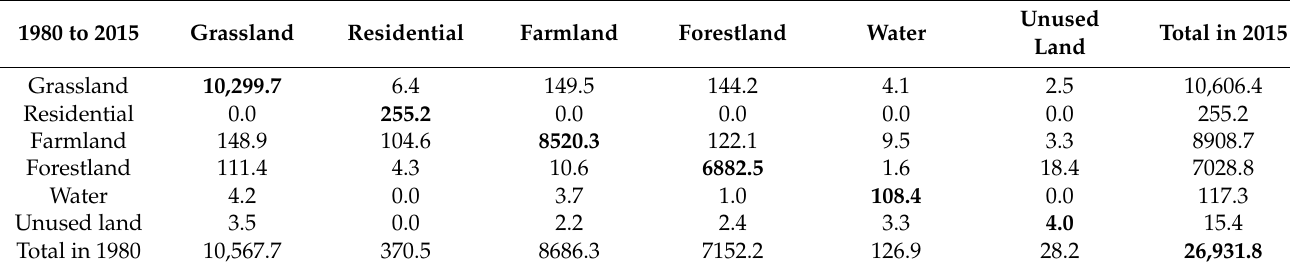
Table 6. Transition matrix of land-use change and total area of different land use from 1980 to 2015 in the Beiluo River Basin (km 2 ).